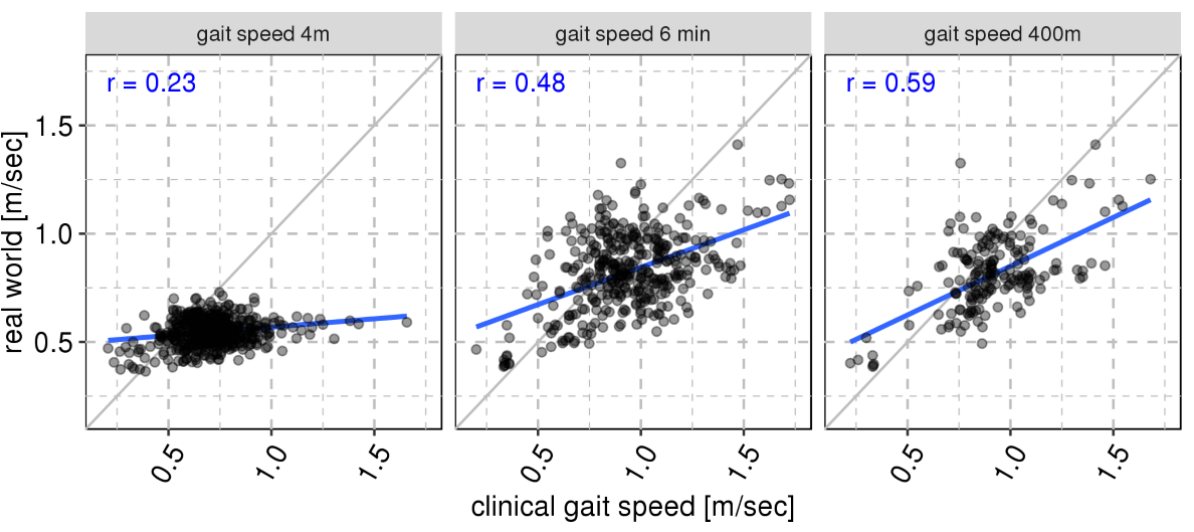
Figure 4. Comparison of in-clinic gait speed performance measures and adjacent real-world gait speed behavior. Only patient visits with at least 3 days and 3 hours per day of wearing in a 20 day window around the visit are included. Gait speed in the 4mWT is compared to real-world gait speed in bouts of length between 5 and &lt;20 steps, and 6MWT and 400mWT gait speeds are compared to real-world gait speed in bouts containing between 80 and &lt;640 steps. Gait speed in the clinical assessment is plotted on the x-axis and real-world gait speed is plotted on the